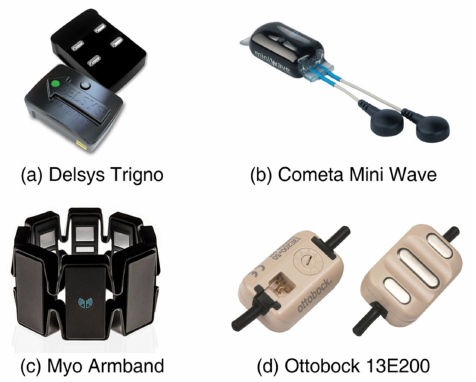
Figure 1. Examples of commercial surface electromyography (sEMG) sensors. ( a ) Delsys